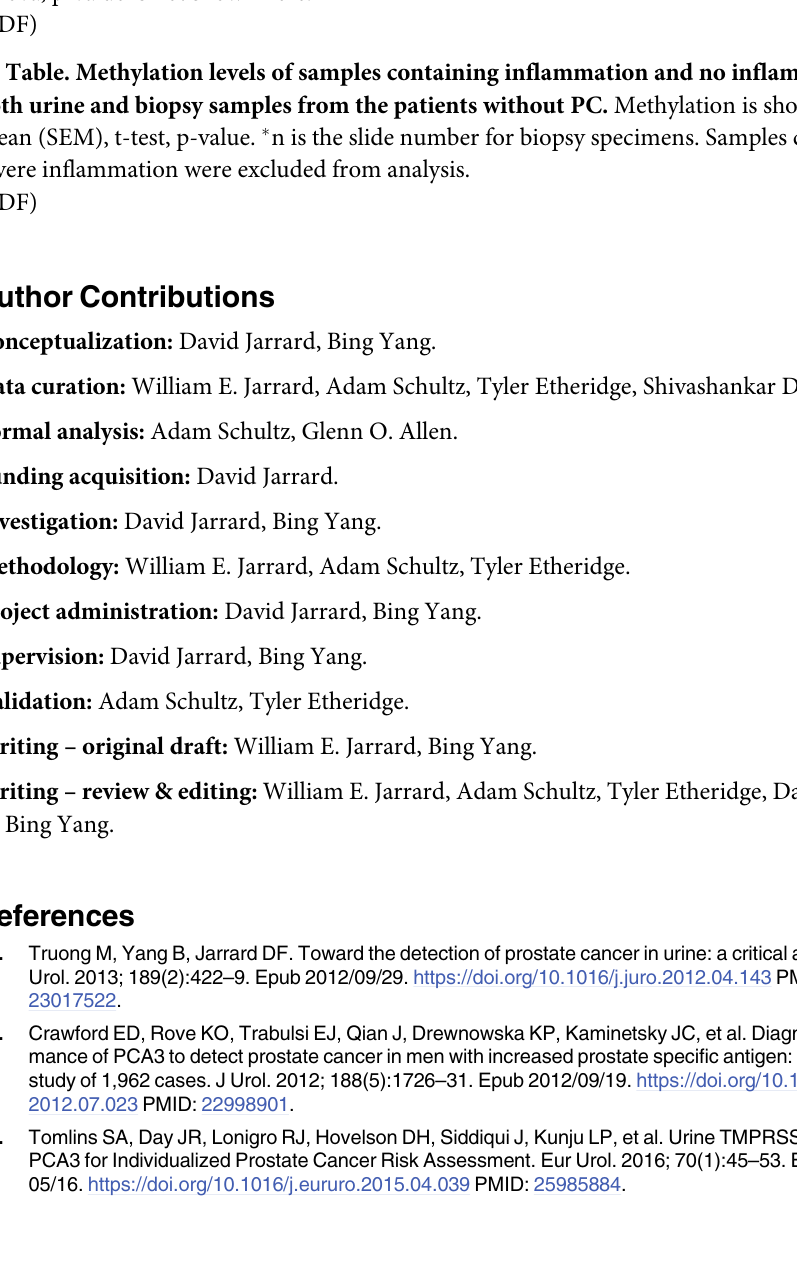
with PC. 176 out of 196 probes are associated with genes, 9 probes are LINC (long intergenic